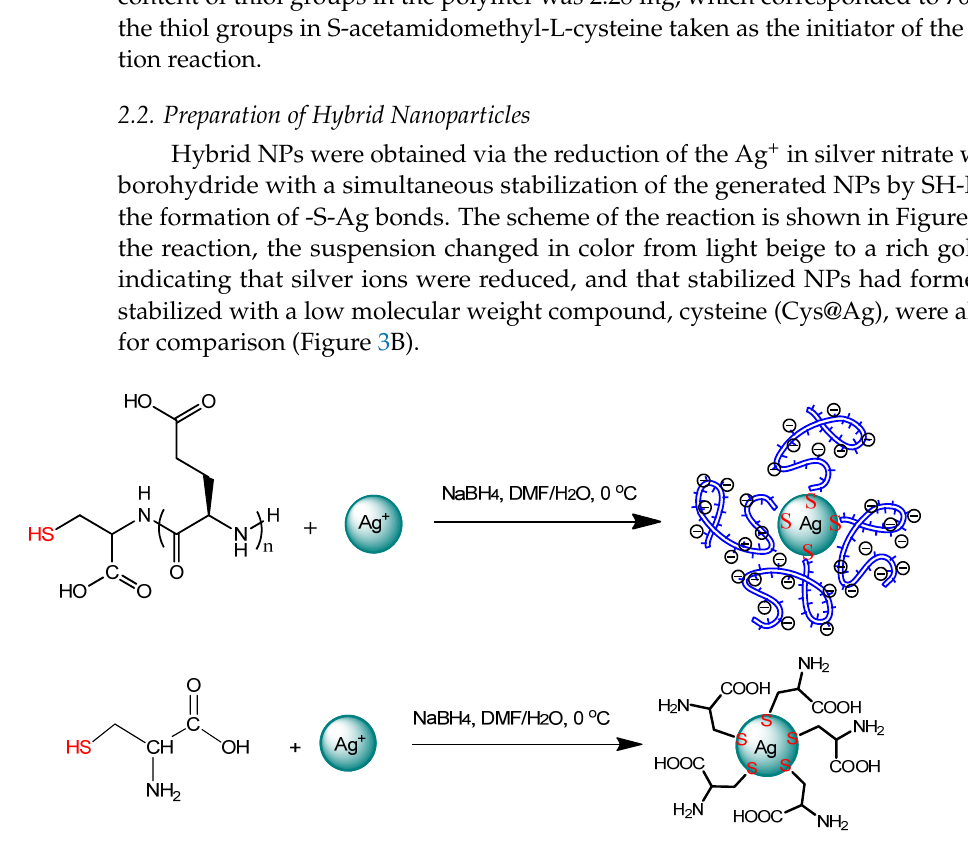
Figure 3. Scheme of preparation of PGlu@Ag ( A ) and Cys@Ag nanoparticles ( B ). Table 1. Characteristics of PGlu@Ag nanoparticles determined by dynamic and electrophoretic light scattering.